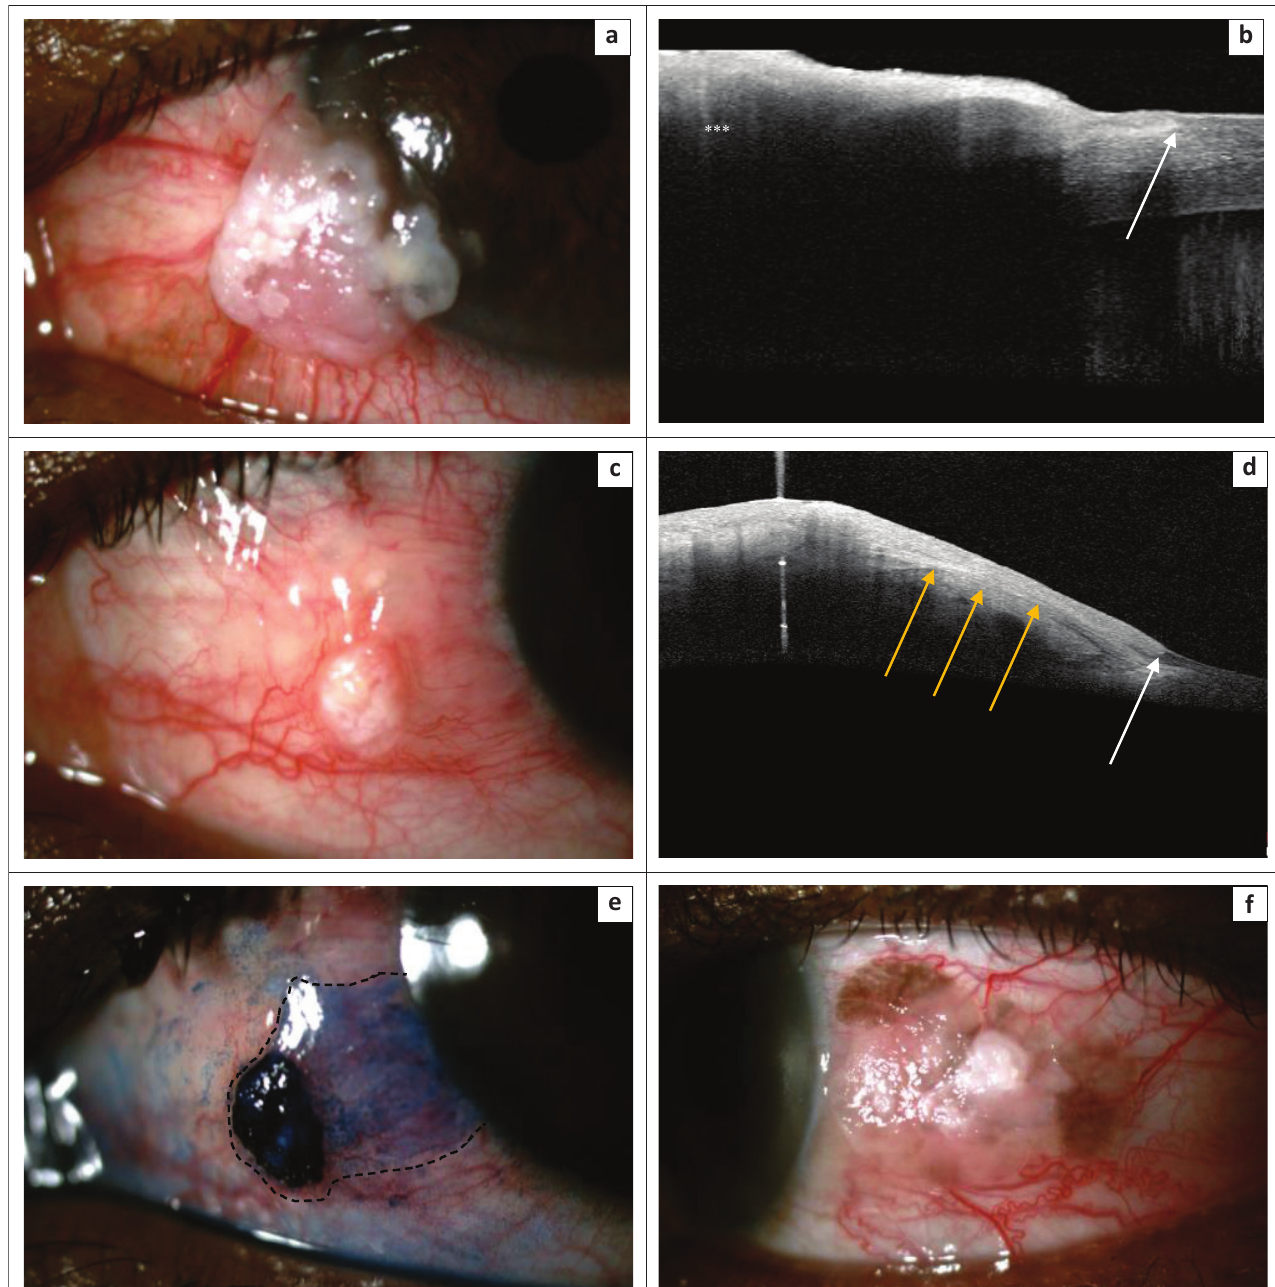
FIGURE 1: (a and b) Anterior segment photograph and anterior segment-optical coherence tomography of a leucoplakic lesion with feeder vessels. Anterior segment- optical coherence tomography (b) showing the transition zone (white arrow) with thickened hyper-reflective epithelium. The leucoplakia has caused shadowing that has masked the demarcation line (white asterisk). (c–e) Anterior segment photographs and anterior segment-optical coherence tomography of a gelatinous lesion. Anterior segment-optical coherence tomography (d) showing the transition zone (white arrow), thickened hyper-reflective epithelium and demarcation line (yellow arrows). (e) The methylene blue stain highlights the extent of the lesion (black dotted line) that is not clinically obvious on slit lamp examination. (f–h) Anterior segment photos and anterior segment-optical coherence tomography of a leucoplakic lesion. The anterior segment-optical coherence tomography (g) shows classic features of ocular surface squamous neoplasia. The methylene blue stain (h) delineates the margins of the